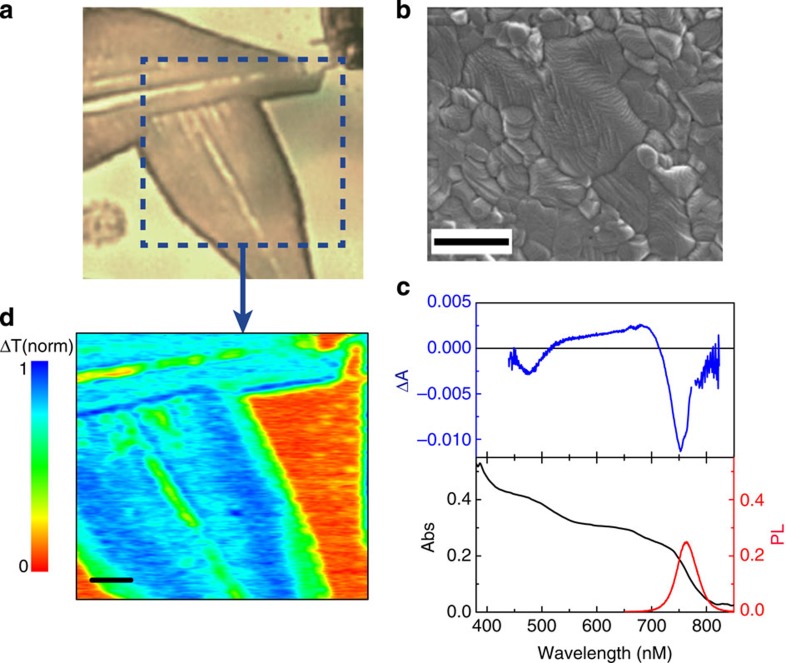
Structural and optical characterizations of CH3NH3PbI3 perovskite film.(a) Optical micrograph of a microcrystalline region in a CH3NH3PbI3 perovskite film. (b) Scanning electron micrograph (SEM) centred within a single representative perovskite flake. The scale bar is 0.5 μm. (c) Upper panel: transient absorbance spectrum measured at 50 ps in the bulk phase; lower panel: absorption and PL spectra of the sample region in (a). (d) Transient absorption imaging of the selected region of perovskite flake (dashed lines in a) at 0 ps. The whole image is 10 × 10 μm in size, with a scale bar of 1 μm.